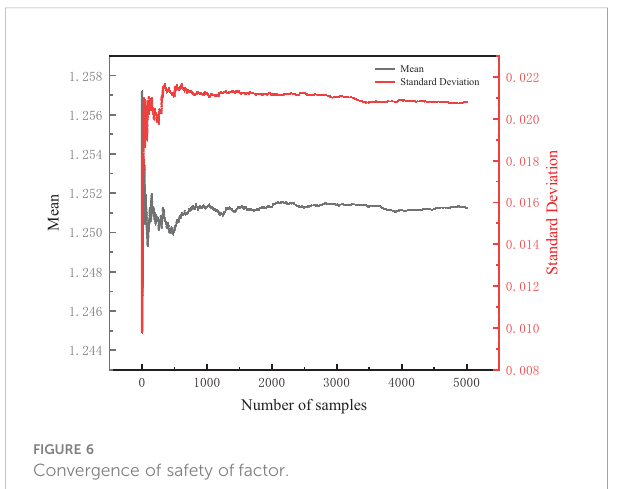
FIGURE 7 Variation of annual failure probability of the Zhaoshuling